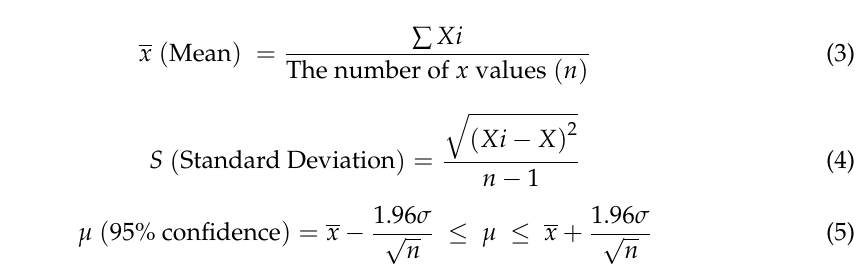
( b ) Figure 8. ( a ) ECG result using the standard Ag/AgCl Electrodes (the blue graph is without filtering and the orange line is after the filtering). ( b ) ECG result using the fabricated electrodes (the blue curve is without filtering and the orange curve is after the filtering). An ECG comparison between the fabricated PANI electrodes and the standard Ag/AgCl electrodes was performed, as shown in Figure 8. The ECG result using the fab- ricated electrodes appeared to be promising, but the signal to noise ratio was a bit higher than that observed in the standard Ag/AgCl electrodes; the reason could be due to the motion artifact or the 50 Hz noise within the room. However, the flexibility of the current electrode material and the absence of other liquid electrolyte material promises for more levels of conformability [23].